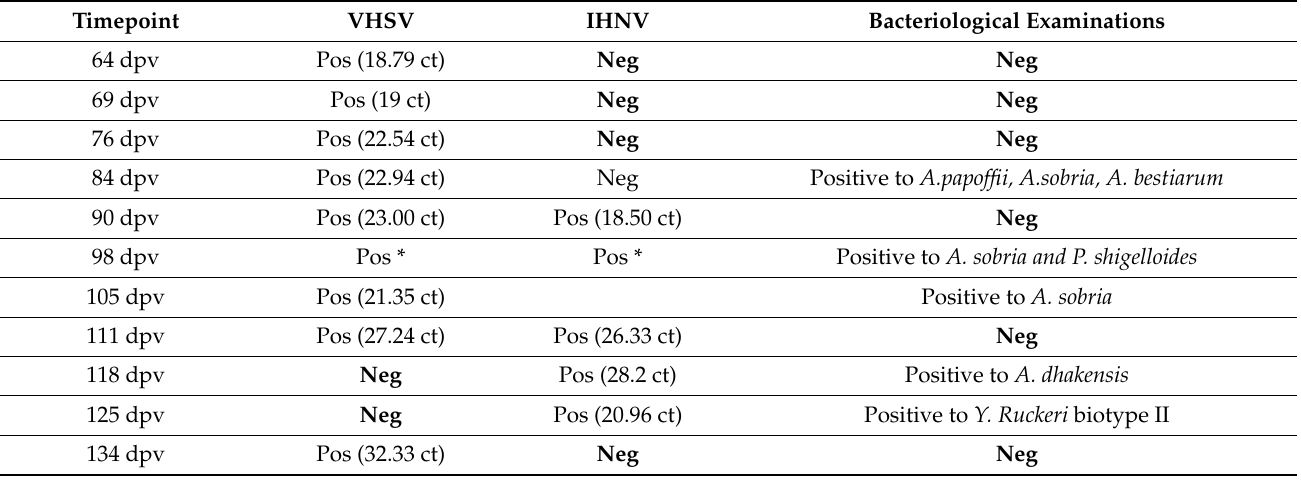
Table 6. Results of the diagnostic examinations performed weekly on pools of moribund/dead fish collected from the mock vaccinated group up to 134 dpv. Numbers in brackets indicate the positive cycle threshold (ct) of real-time RT-PCR. dpv = day post-vaccination. Samples marked with * were evaluated by viral isolation on cell culture.